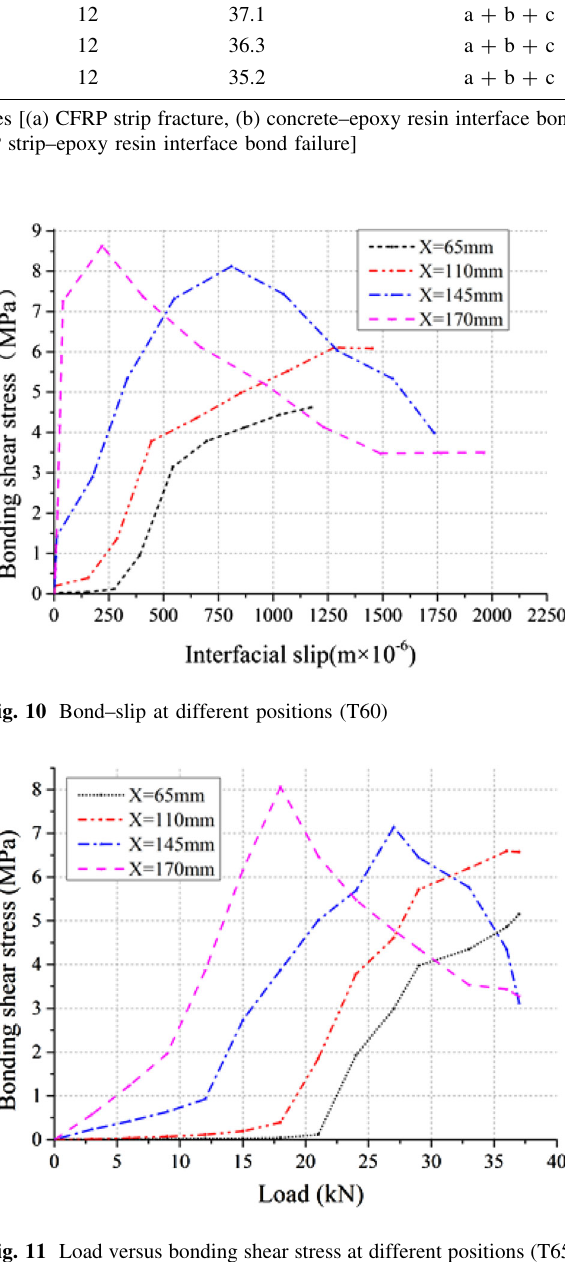
Fig. 11 Load versus bonding shear stress at different positions